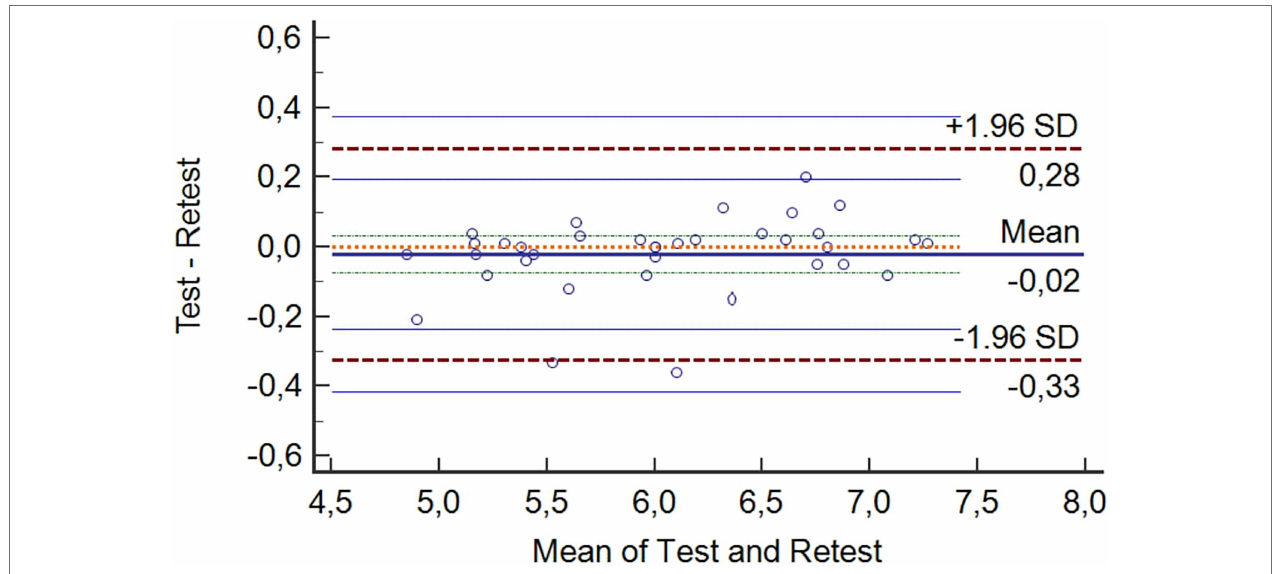
FIGURE 2 | Bland and Altman plots for the specific karate agility test–retest performances.